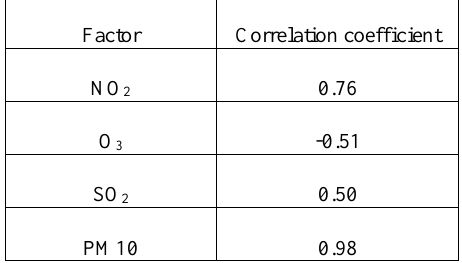
Table 1. Correlation coefficient between PM2.5 and